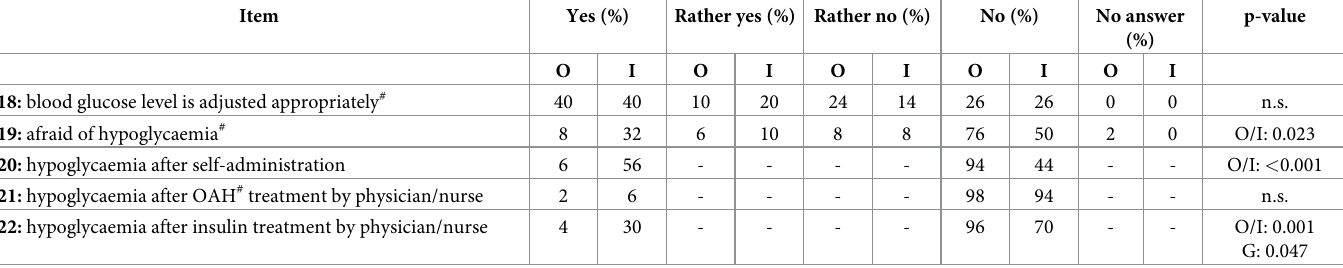
Table 4. Diabetes specific aspects (group I = insulin; group O = oral antihyperglycaemic agent). Differences were calculated between both groups (O/I), duration of diabetes (D), age (A), gender (G) and education level (E). Any significance is given in the column “p-value” (n.s. = not significant). Significant differences for duration of diabetes, age, gender and education level are indicated in the description below the table.